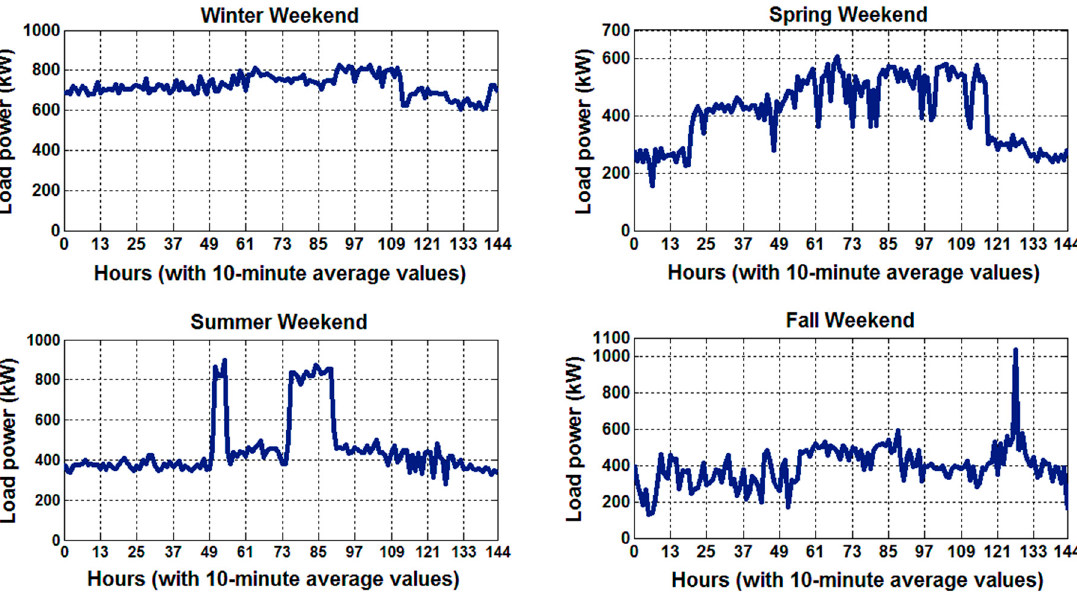
Figure 4. Sample weekend/holiday load demand curves, with 10-min average values; for winter